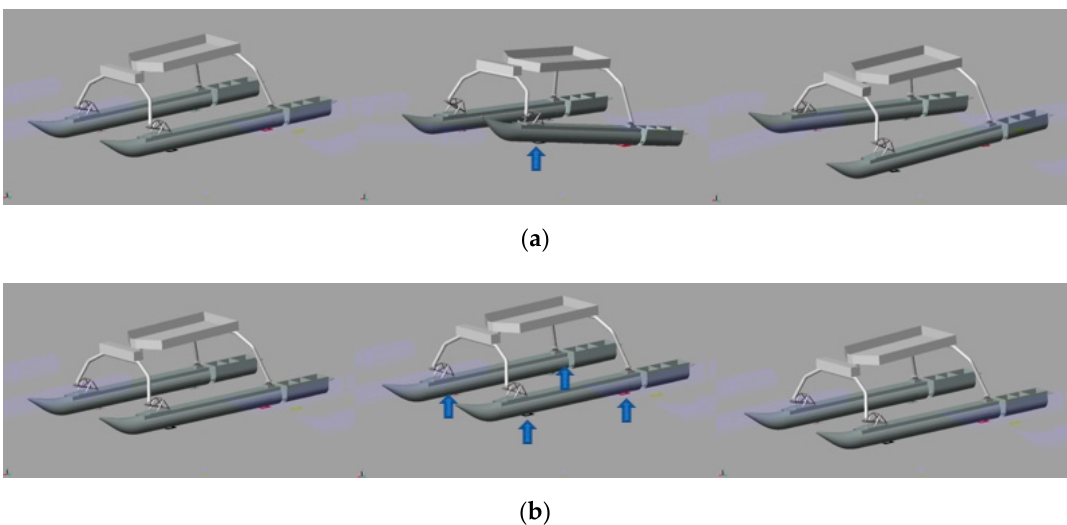
Figure 11. Simulation animation screenshots with different wave impacts. ( a ) Simulation with bow waves; ( b ) Simulation with large heave motion. waves; ( b ) Simulation with large heave